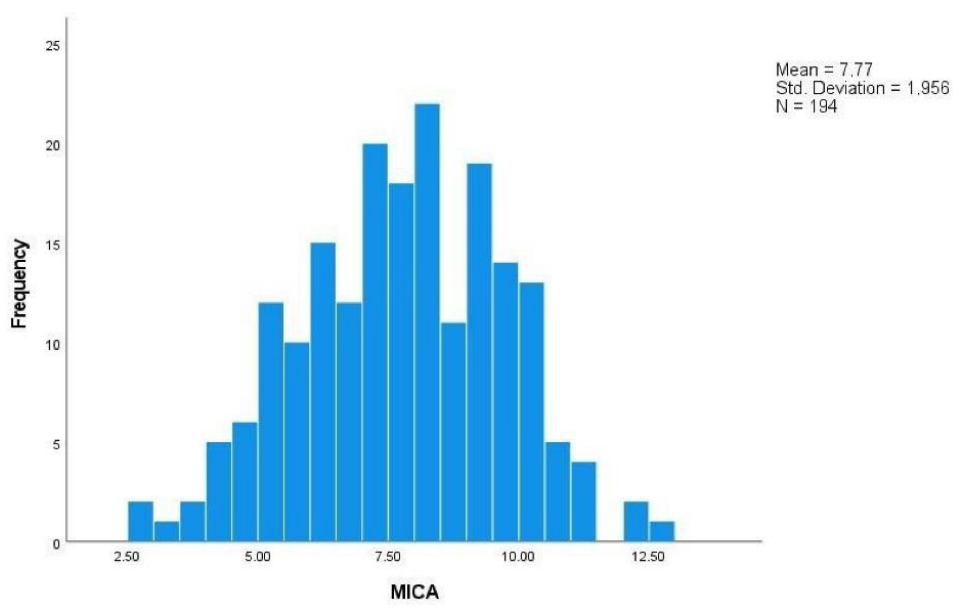
Figure 1. Histogram of the distribution of the Gupta Perioperative Risk for MICA Score. Abbreviations: MICA — Myocardial Infarction and Cardiac Arrest score; SD — Standard Deviation.